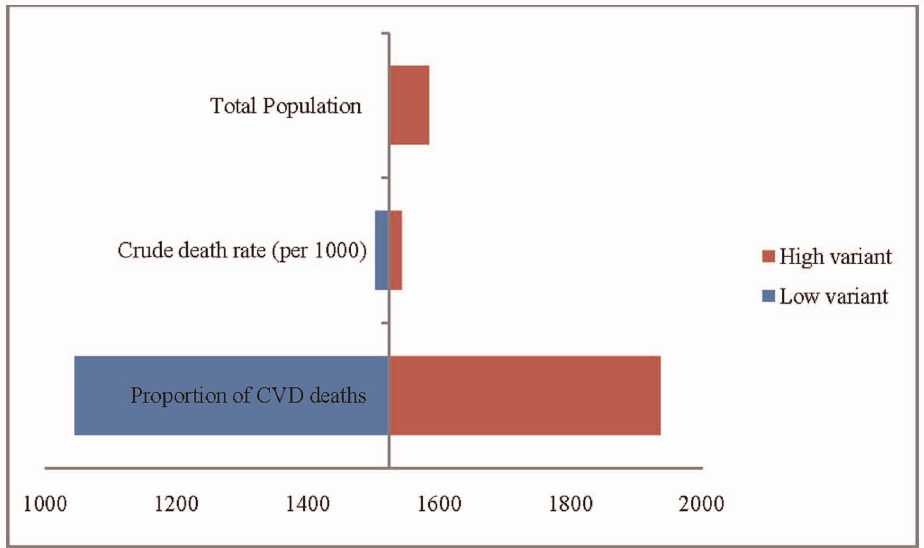
Figure 1. Sensitivity analysis for the estimates of CVD deaths by varying three parameters, India, 2004.